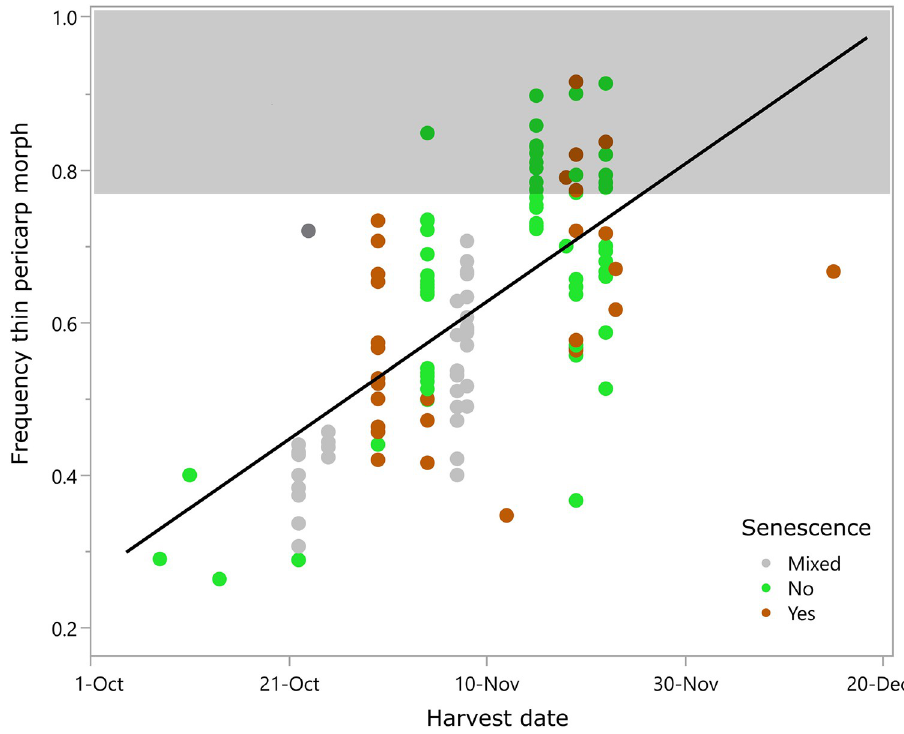
Fig 4. Correlation between the percent thin pericarp morphs in the harvest and the harvest date with line of best fit. Points within the shaded area are outside the range of variation documented for free-living erect knotweed.